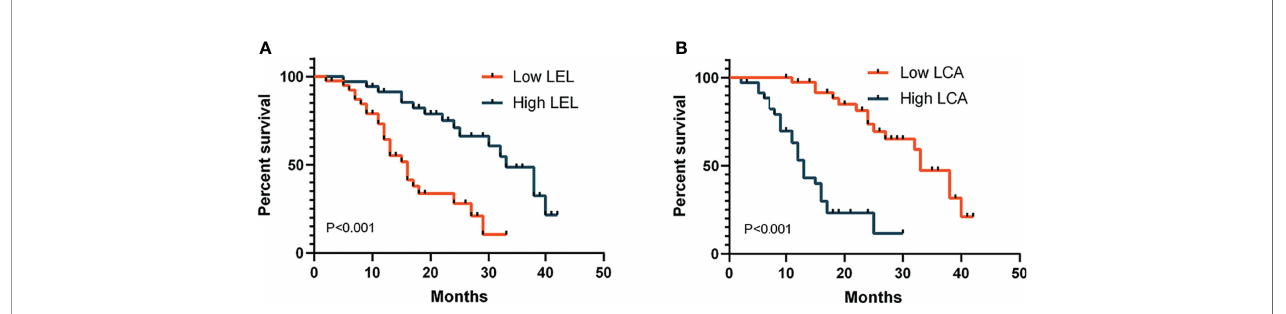
FIGURE 4 | Kaplan – Meier analysis of dialysis-free survival in patients with diabetic nephropathy. Subjects were dichotomised based on the mean of the covariates: (A) 0.036 for LEL; (B) 0.060 for LCA. p-Values refer to log-rank tests. LEL, Lycopersicon esculentum lectin; LCA, Lens culinaris lectin.